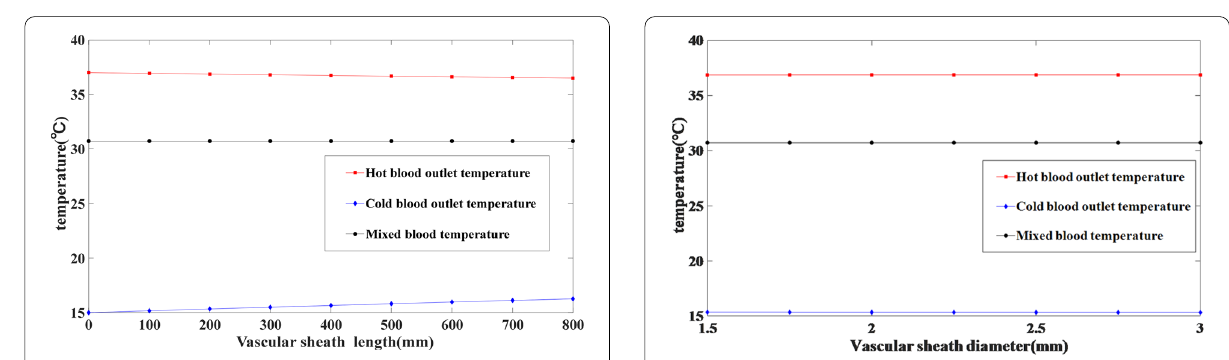
Figure 10 Output temperature trend curves influenced by vascular sheath diameter during countercurrent